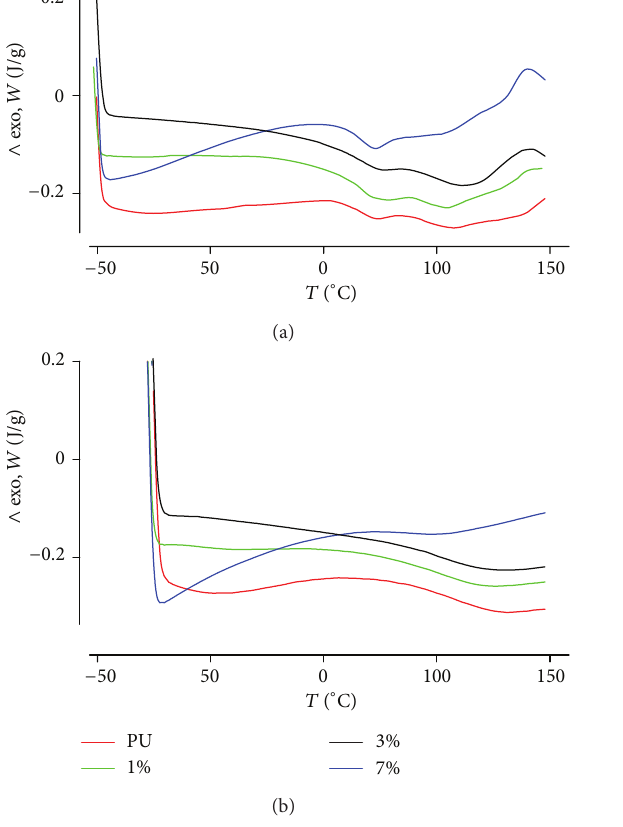
Figure 6: DSC curves of PU and PU/OMMT nanocomposites: (a) the 1st and (b) the 2nd heating.